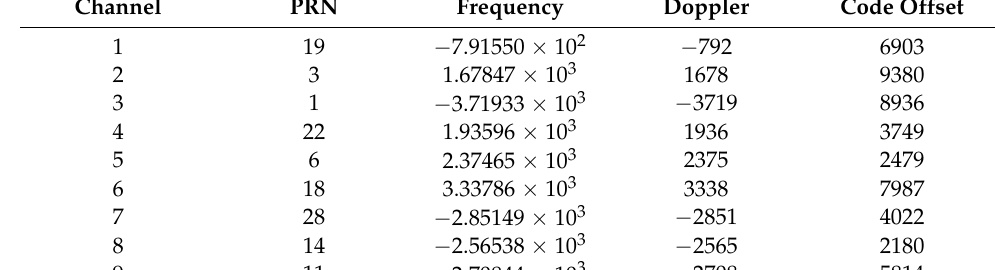
Table 2. Summary of the acquisition results.